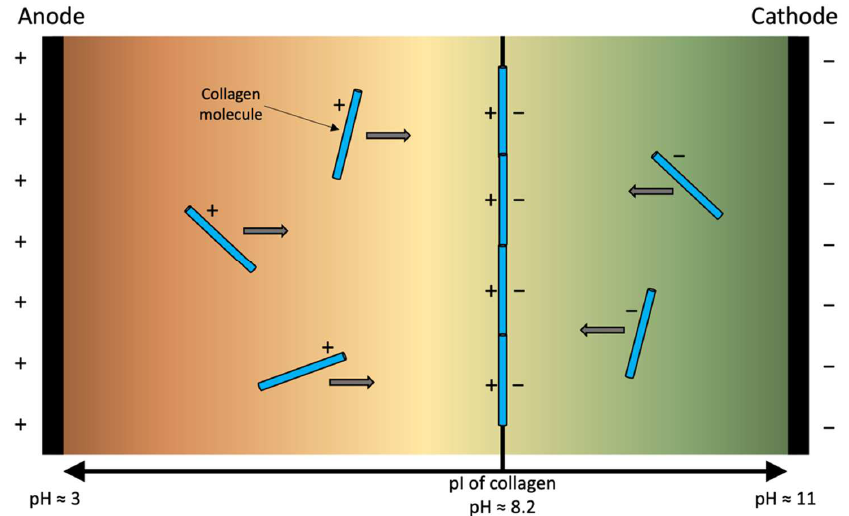
Figure 4. Schematic of collagen electro-compaction, illustrating the anode and cathode with associated charges and generated pH gradient, and demonstrating the charges gained by the collagen molecules and the aggregation at the isoelectric point (pI), where the net charge is 0.